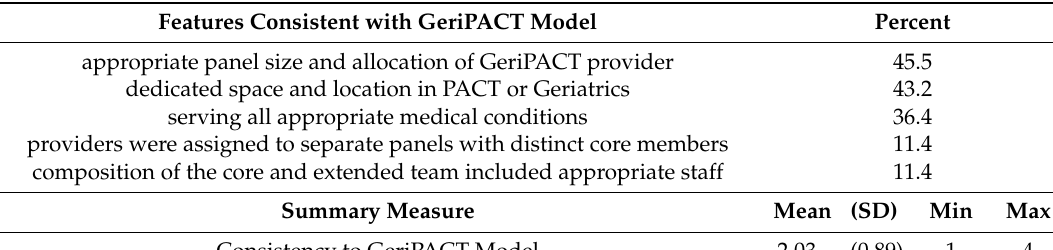
Table 5. Consistency to the GeriPACT Model (N =